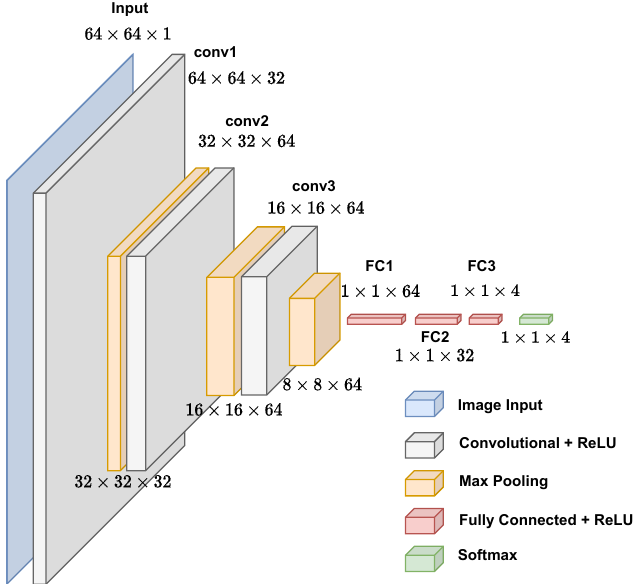
Figure 2. Graphical representation of proposed convolutional neural network for virus genome classification.